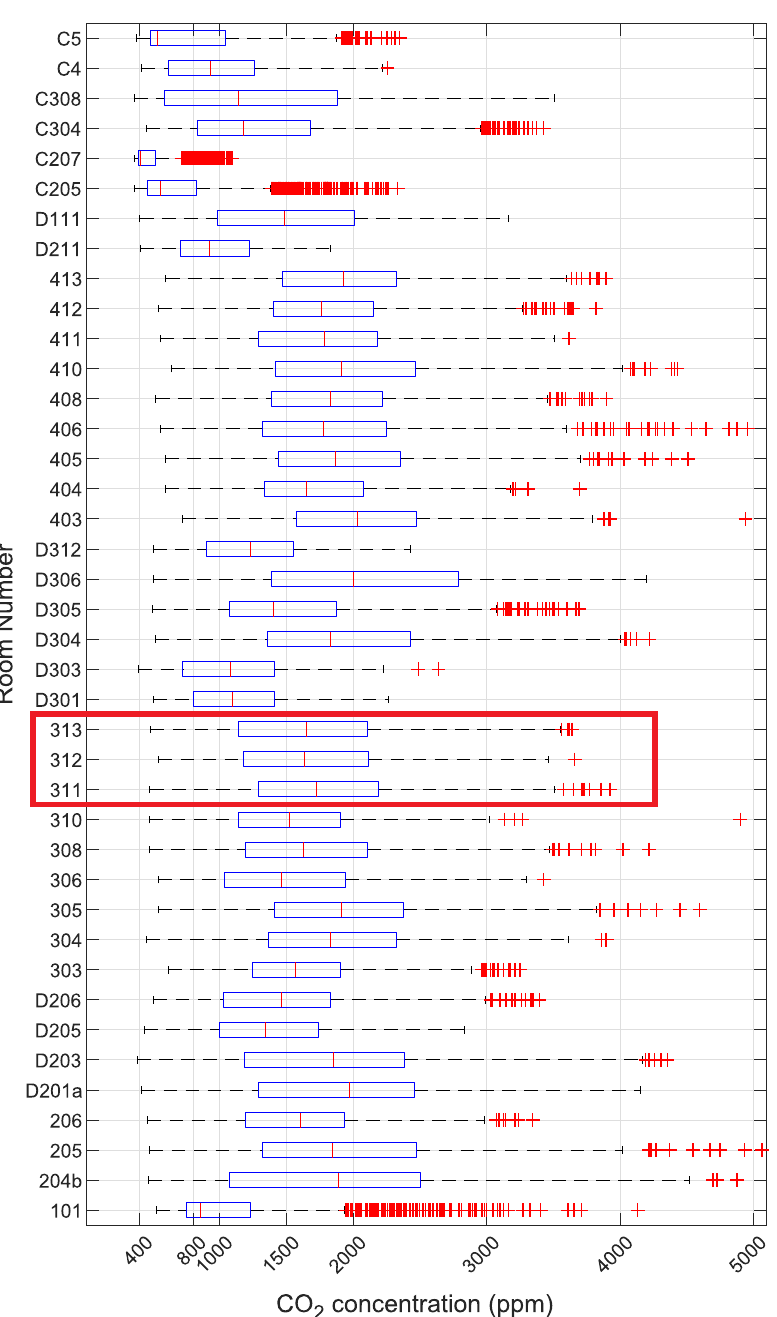
Figure 14. Horizontal boxplot for the January 2019 at the Grammar School and Secondary School of Electrical Engineering and Computer Science, Frenštát pod Radhoštˇem; The red box means the classrooms that are further analyzed in this case